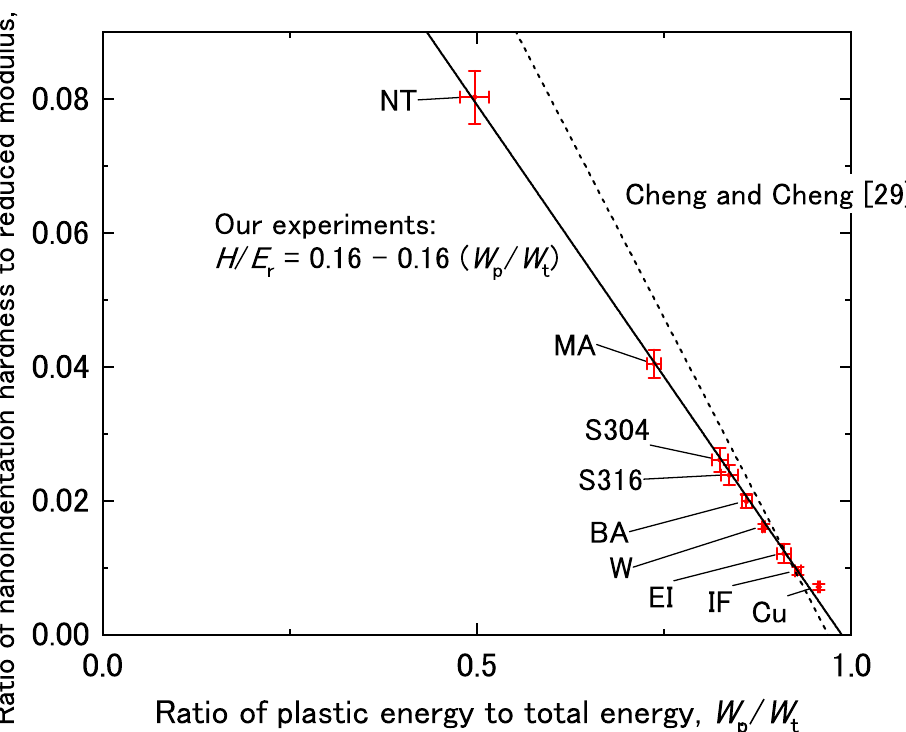
Figure 3. Ratio of nanoindentation hardness to reduced modulus ( H / E r ) as a function of the plasticity index ( W p / W t ). The error bars are drawn with the standard deviation.